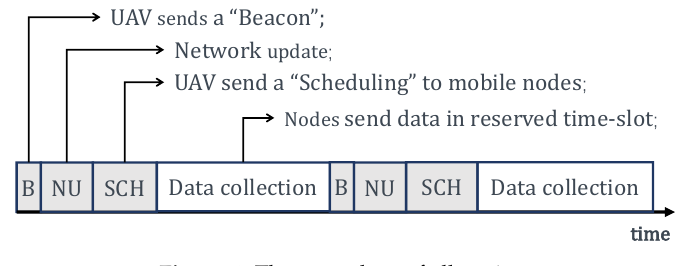
Figure 4. The procedure of